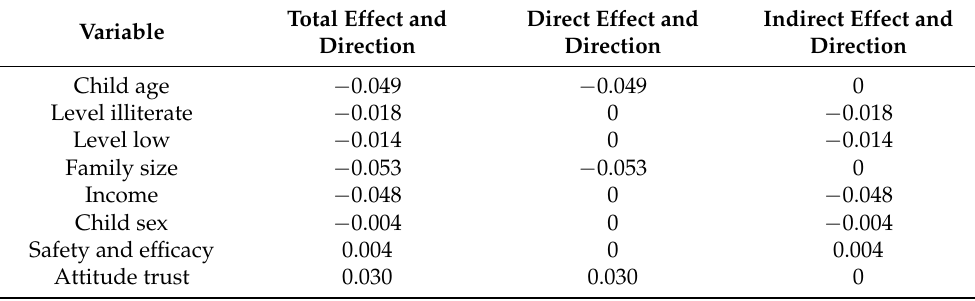
Table 4. Value and direction of the total, direct, and indirect effect of exogenous (indirect) endogenous (direct) variables .